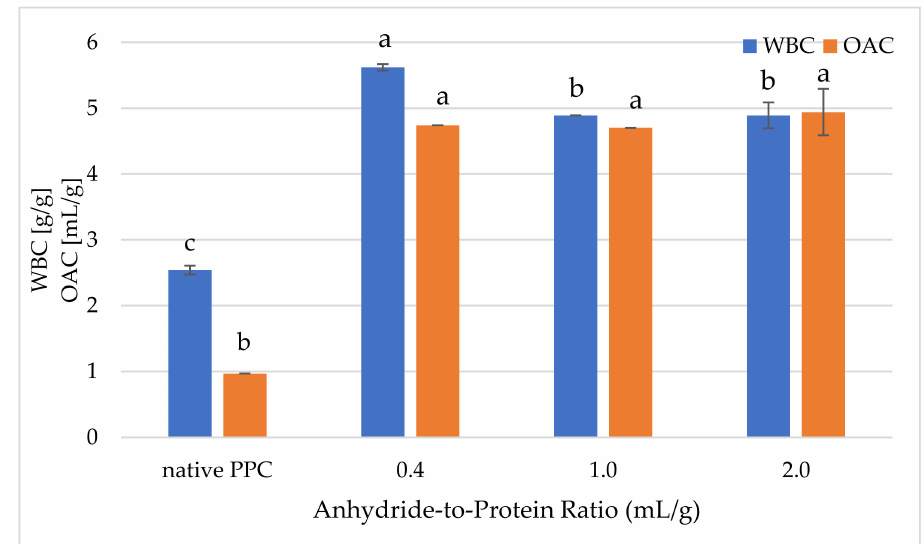
Figure 3. Effect of anhydride-to-protein ratio on water-binding capacity (WBC) and oil-absorption capacity (OAC) of native and acetylated PPC. a,b,c —the same letters within the same analysis were not significantly different; PPC—pumpkin protein concentrate; 0.4, 1.0, 2.0—pumpkin protein prepa- rations after acetylation conducted with different concentrations of acetic anhydride